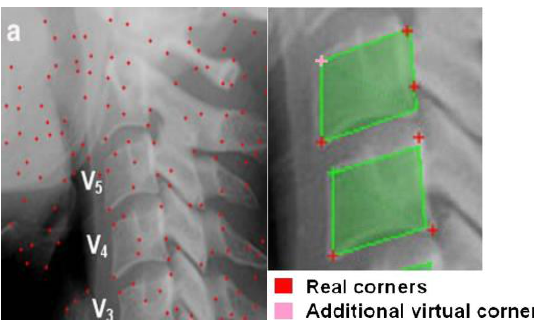
Figure 1. (a) Corner detection results using the Harris detector. (b) Adding a virtual anterior face corner (if this one is not detected); (Source: Benjelloun & Mahmoudi, 2009)